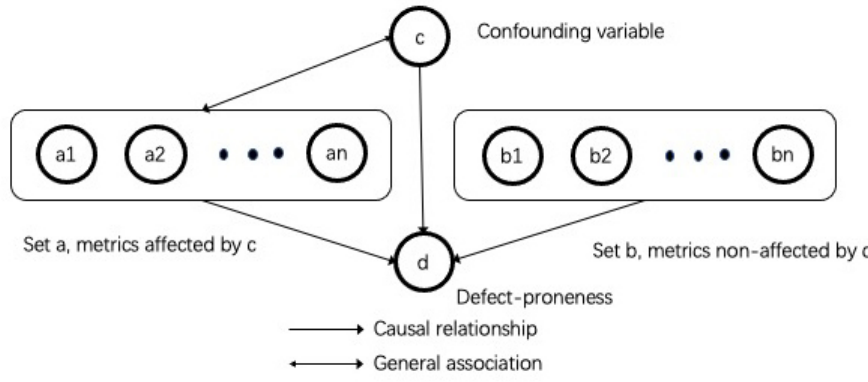
Figure 2. An improved confounding effect